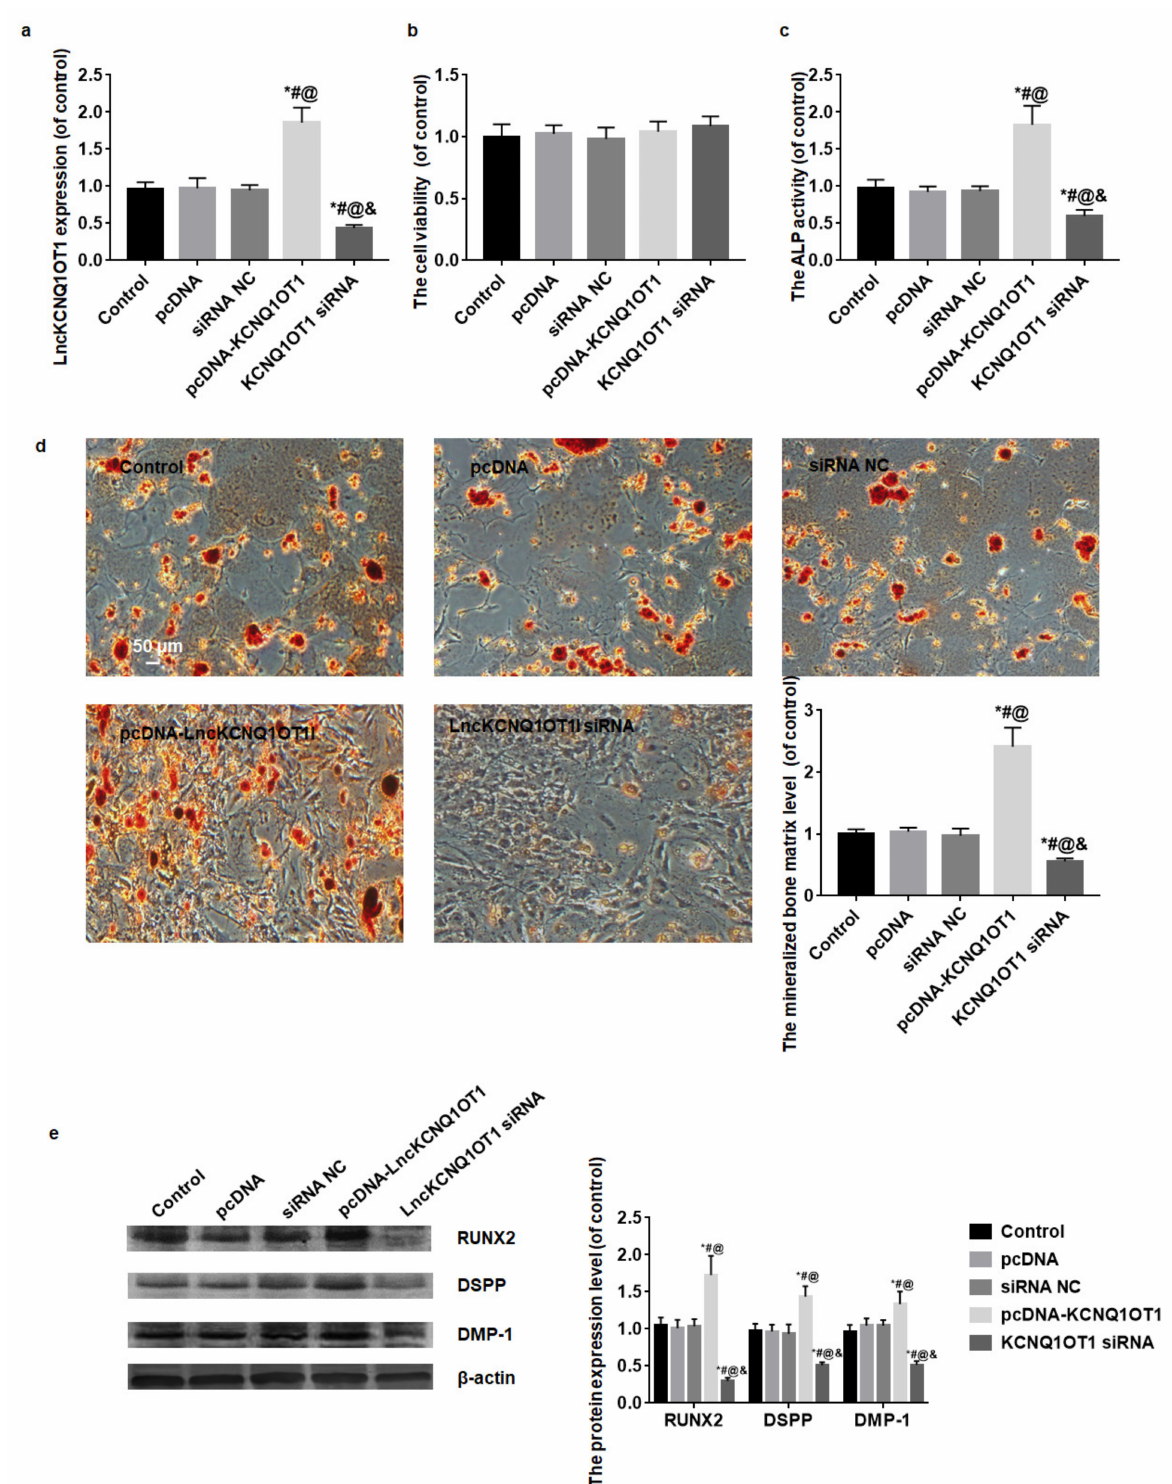
Figure 2. The effect of LncKCNQ1OT1 on the cell viability and odontoblastic differentiation of DPSCs. ( a ) LncKCNQ1OT1 expression level of DPSCs transfected with pcDNA-KCNQ1OT1 significantly increased and that of DPSCs transfected with KCNQ1OT1 siRNA notably decreased. ( b ) The trans- fection did not affect the viability of DPSCs. ( c ) After 14 days of odontoblastic differentiation,